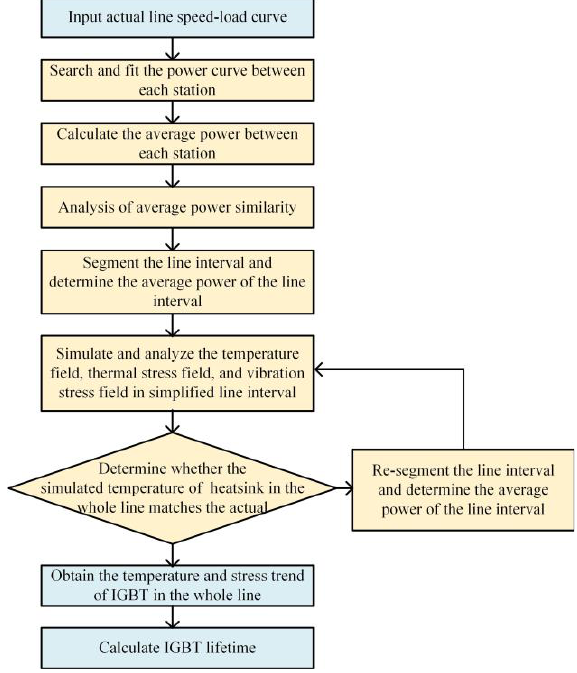
Figure 8. The flow chart of proposed method.